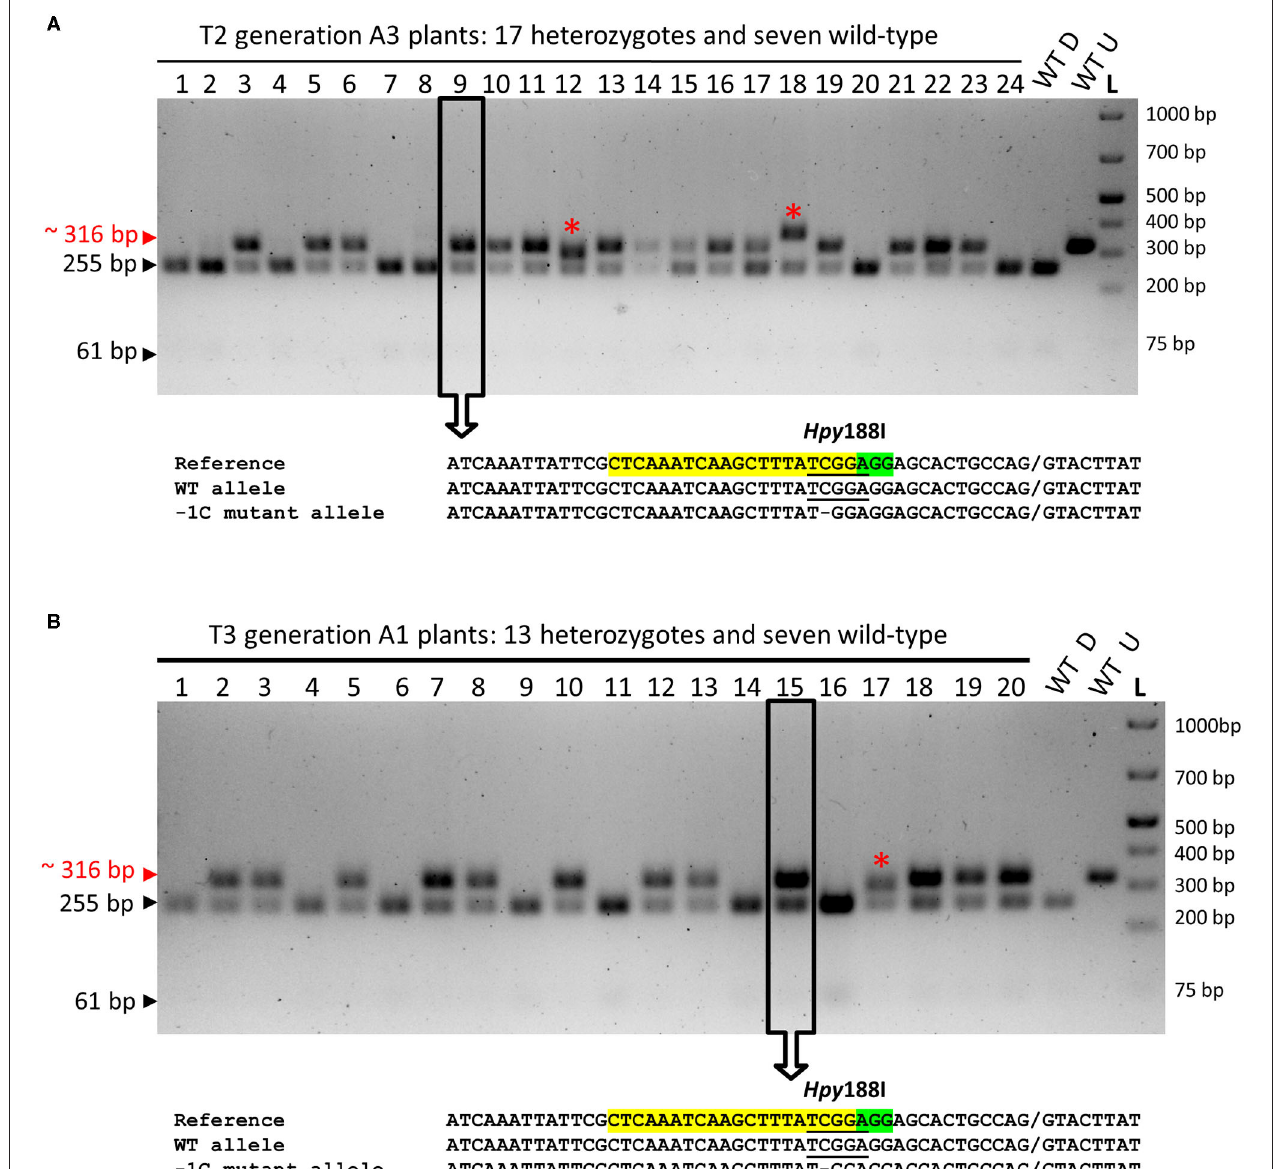
FIGURE 5 | PCR-RE genotyping of the emerged T2- and T3-generation plants for the on-target mutations in the HvMPK6 gene. (A) PCR-RE genotyping of 24 (1–24) T2 progeny plants of A3 heterozygous mutant (WT/ − 1C). (B) Representative results of PCR-RE genotyping of T3 progeny plants of A1 and A2 heterozygous mutants (WT/ − 1C). In particular, the results of PCR-RE genotyping of 20 (1–20) T3 progeny plants of A1 heterozygous mutant (WT/ − 1C) are shown. Genomic DNA for the mutation analysis was extracted from the leaves of the transgenic plants. About 316-bp PCR amplicons of the genomic region covering the on-target site were digested with Hpy 188I. The red arrowhead and red typing of the size of the PCR product indicate undigested PCR amplicons containing mutation which disrupt the Hpy 188I recognition site. Black arrowheads and black typing of the sizes of the PCR products indicate the digested WT PCR amplicons. Wt D—digested and Wt U—undigested reference 316-bp amplicons associated with WT plant. L-O’GeneRuler 1kb Plus DNA Ladder (Thermo Fisher Scientific, Waltham, MA, USA). Sizes of the selected ladder fragments are shown on the right. None of the analyzed plants is a homozygous mutant. The asterisk indicates a rare heterozygous restriction pattern. Several PCR products associated with a common heterozygous restriction pattern (examples in open rectangles with an arrow) were sequenced, and the resulting superimposed chromatograms were decoded into allelic nucleotide sequences (bellow electrophoreograms) with the DSDecodeM tool (Liu et al., 2015b). The selected nucleotide sequence region of the WT HvMPK6 allele is shown as a reference on the top of each multiple sequence alignment with the gRNA on-target site and the PAM site highlighted in yellow and green, respectively. The designation of an allele is shown on the right. Slash indicates an exon/intron boundary and dash indicates a single-nucleotide deletion. Where present, the Hpy 188I recognition site is underlined. Mutated allele associated with the common heterozygous restriction pattern contains a single GC deletion at the third nucleotide position upstream of the PAM site ( − 1C allele).